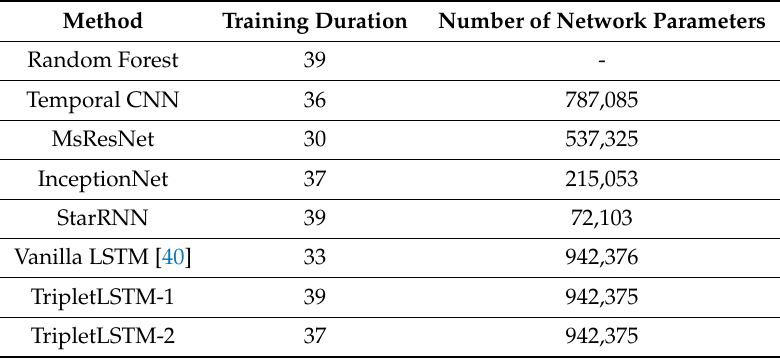
Table 3. Training durations in minutes and network